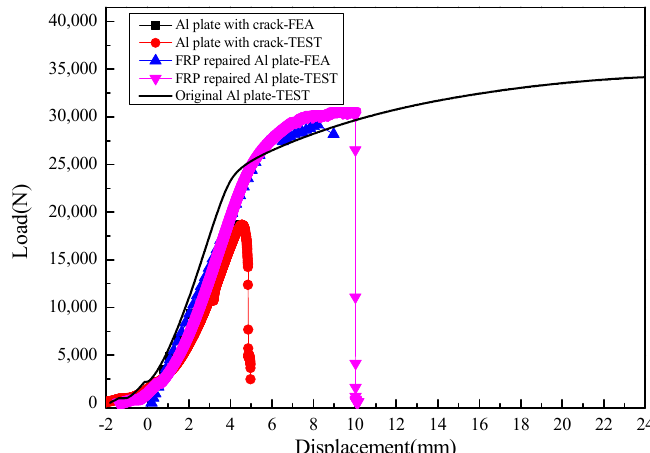
Figure 9. The comparison of load-displacement curves obtained from FEM and experiments.